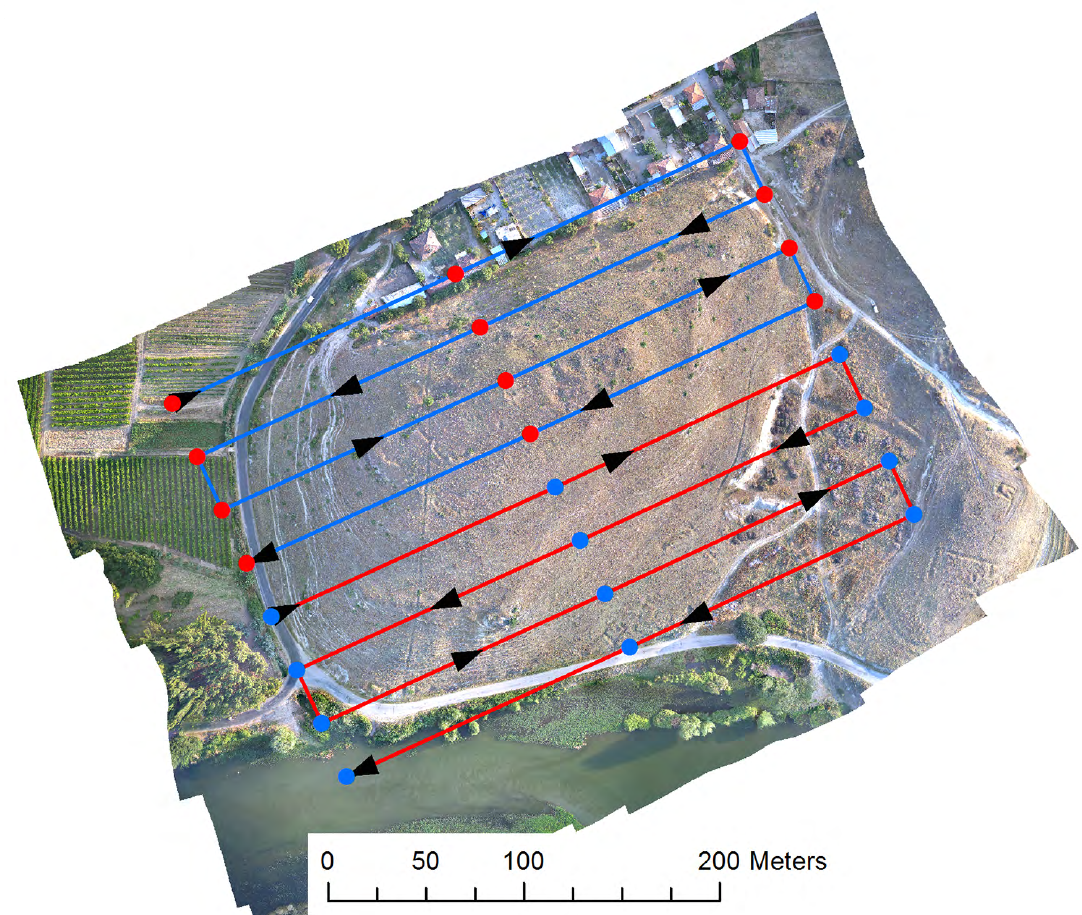
Figure 6: Orthophoto of Asar Tepe 1, showing waypoints and planned paths for two Table 3: Agisoft Photoscan Pro models produced from UAVP, showing number of survey flights, average flight altitude (m agl),